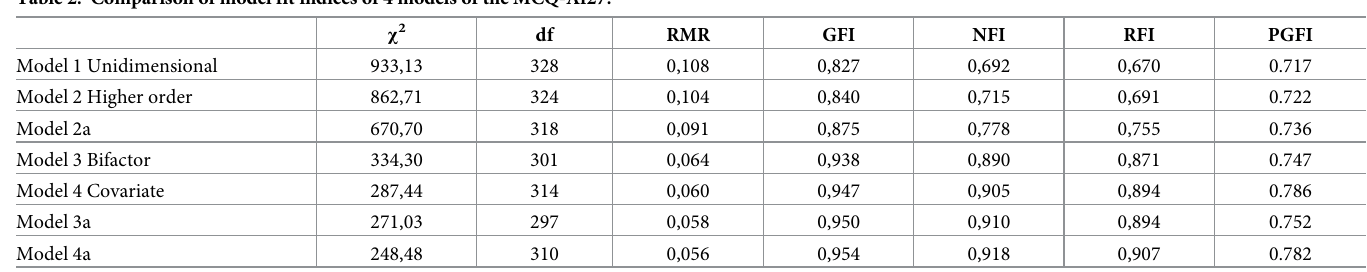
Table 2. Comparison of model fit indices of 4 models of the